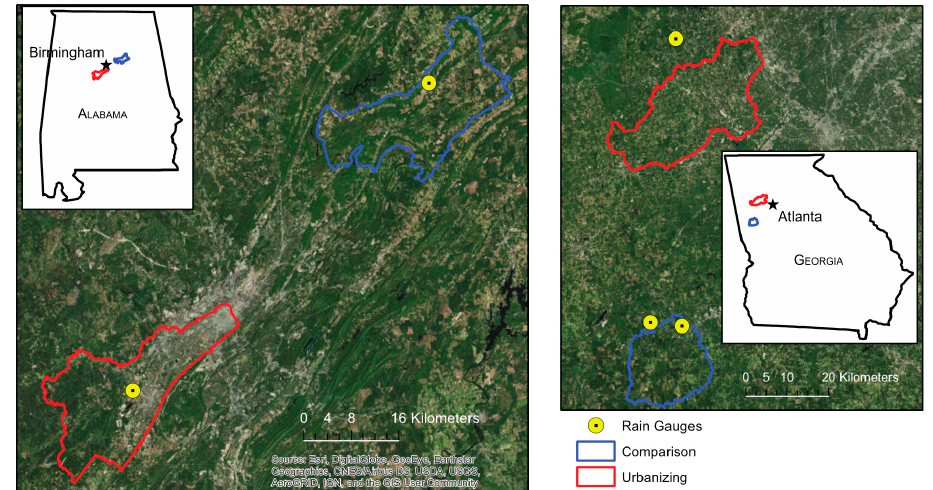
Figure 1. Location of study watersheds and rain gauges in Alabama and Georgia, USA. Table 1. Study watershed characteristics including the location of the outlet gauging station and the year that was determined as the breakpoint between the before and after urbanization periods.